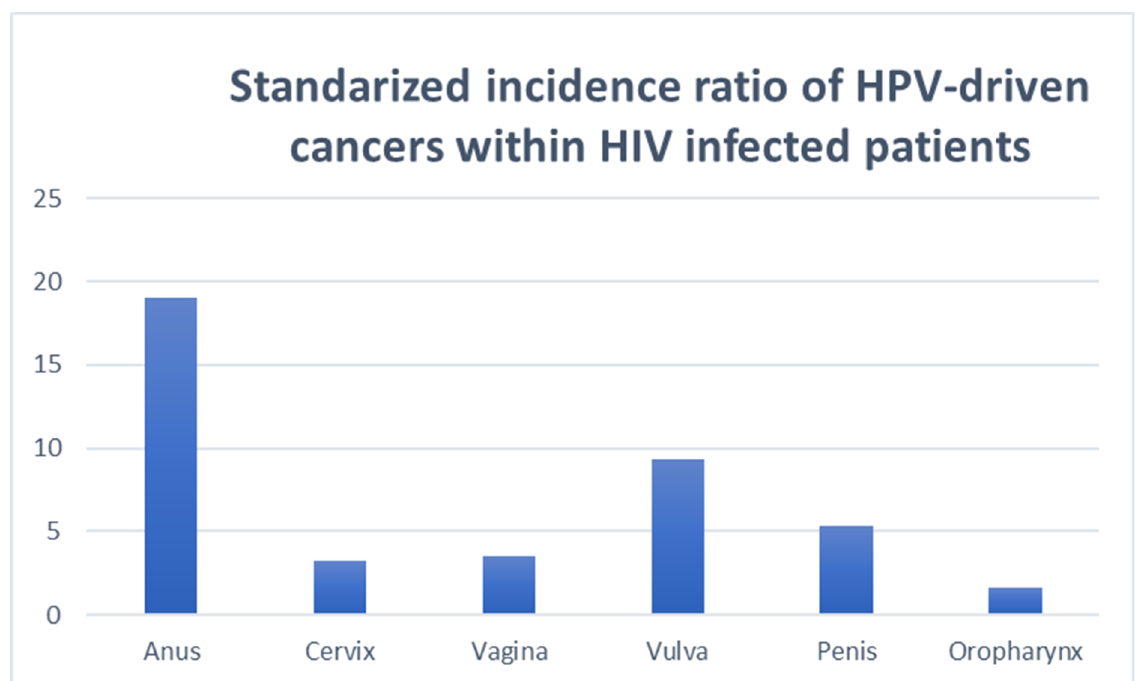
Figure 6. The standardized incidence ratios of HPV-related cancers in people living with HIV. Cervix SCC is the most common HPV-related cancer worldwide, with an adjusted incidence ratio in 2020 of slightly over 7 cases per 100,000 inhabitants in high-income countries [56]. Cervical SSC accounted for approximately 300,000 deaths per year but with variable geographic distributions [57]. The incidence of cervix SCC was higher in low-income regions and remained one of the most frequent causes of death in several countries in Africa [58,59]. The incidence of cervical SCC is roughly fourfold higher in women living with HIV compared with their HIV-uninfected counterparts [60]. Vaginal and vulvar dysplasia are approximately 100-fold less common than cervical dysplasia. Notably, the incidence of vaginal SCC has remained stable over the last few decades, accounting for around 8000 cases per year in the United States [61,62]. Vulvar SCC is also uncommon, and most cases are diagnosed in women living with HIV